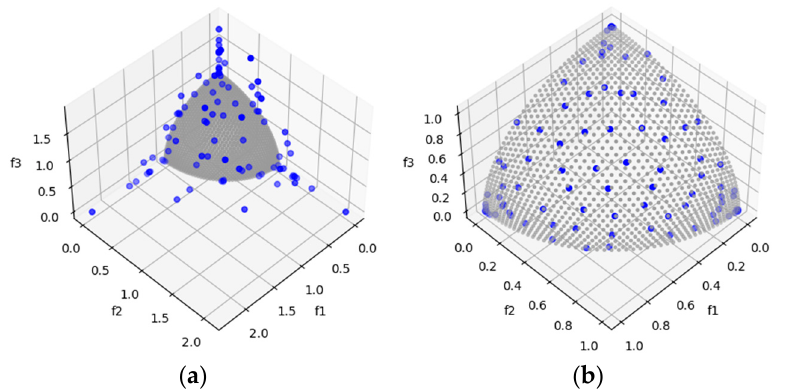
Figure 4. The plots of the approximate PFs with the highest HV value against real PF. ( a ) DTLZ2 approximate PF using MOSA/D-CGO; ( b ) DTLZ2 approximate PF using MOSA/D-DE.